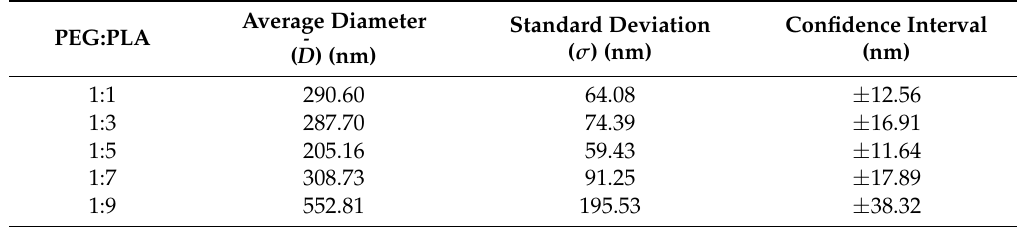
Table 2. The relationship between the weight ratio (PEG:PLA) and the average diameters of CNFs.